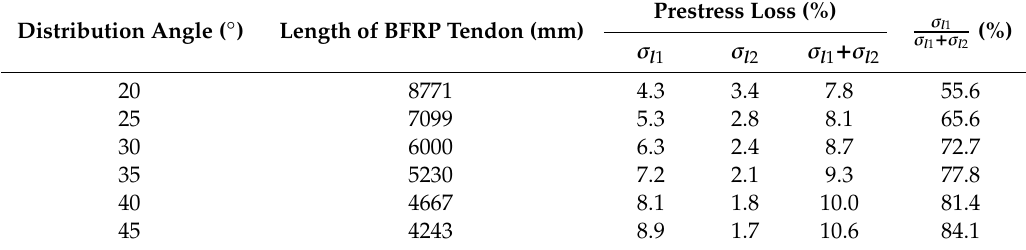
Table 2. Theoretical prestress loss of BFRP tendons given the slab width of 3.0 m. Distribution Angle ( ◦ )